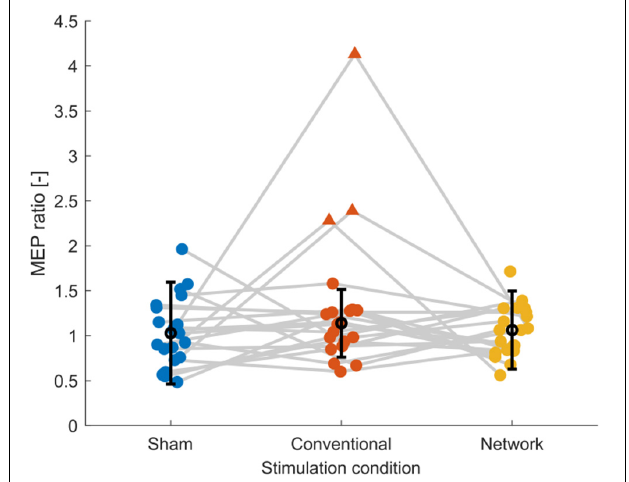
FIGURE 2 | Scatter plot of the post-tDCS/pre-tDCS MEP ratio for sham, conventional, and network tDCS. Each data point corresponds to a single subject. Three subjects, shown as triangles, were considered outliers [outside the median (black marker) ± 1.5 times the interquartile range (error bars)], explaining the high standard deviations and the relatively high group response observed after conventional tDCS. Data of the same subject are connected with gray lines. Jitter was applied to the plot to enhance the readability. Figure created using eeglab.